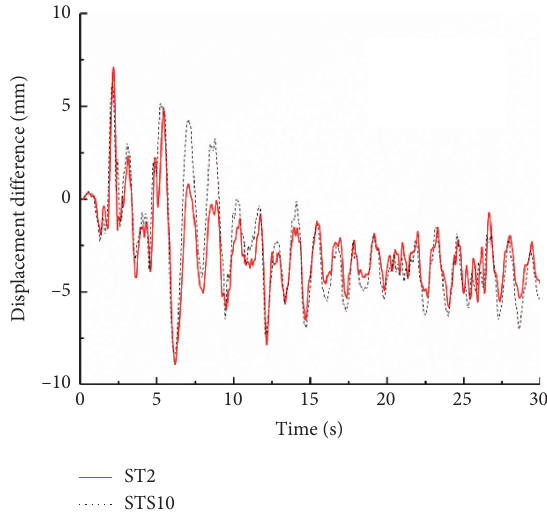
Figure 16: Relative displacement between the top and bottom of the tunnel.